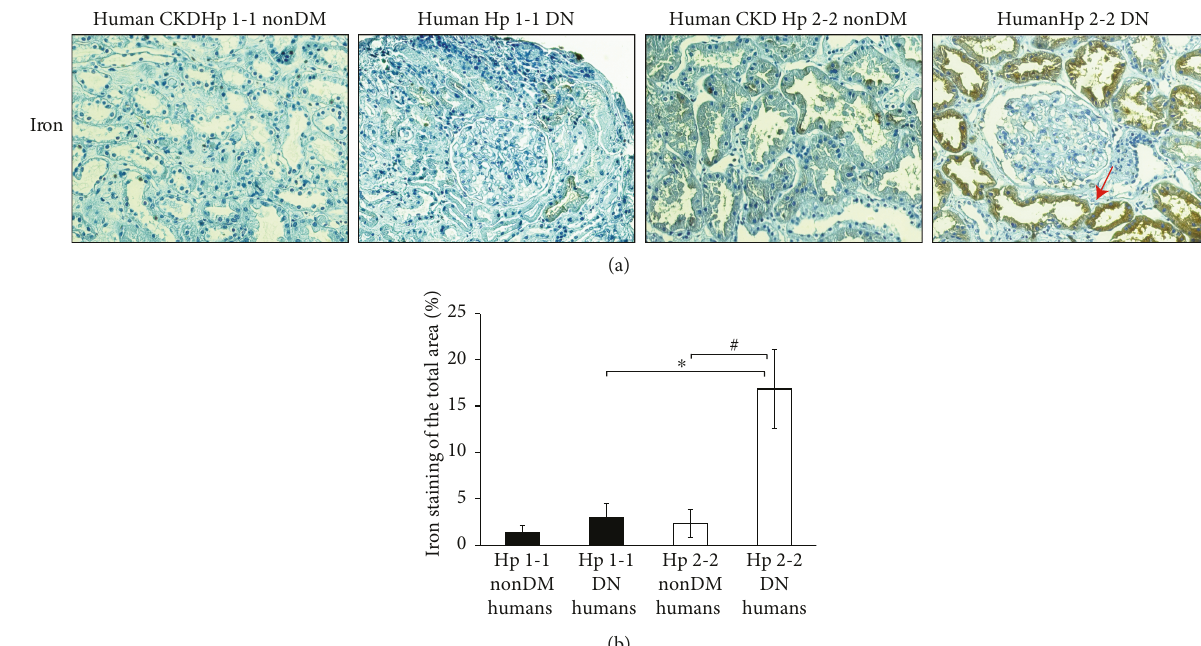
Figure 2: Iron staining in Hp 2-2 and Hp 1-1 renal sections of diabetic nephropathy and nondiabetic CKD patients. (a) There was a signi fi cant increase of iron deposits represented by the DAB-enhanced Prussian blue staining (brown, indicated by a red arrow) in the PCT of Hp 2-2 diabetic nephropathy (DN) patients compared with DN Hp 1-1 or Hp 2-2 CKD nondiabetic (nonDM) patients. (b) Quanti fi cation of the iron staining shows a signi fi cant increase in the percentage of the iron-stained area of Hp 2-2 DM patients compared with the DN Hp 1-1 genotype ( ∗ p < 0 001 ) or compared with the nonDM CKD Hp 2-2 genotype ( # p < 0 001